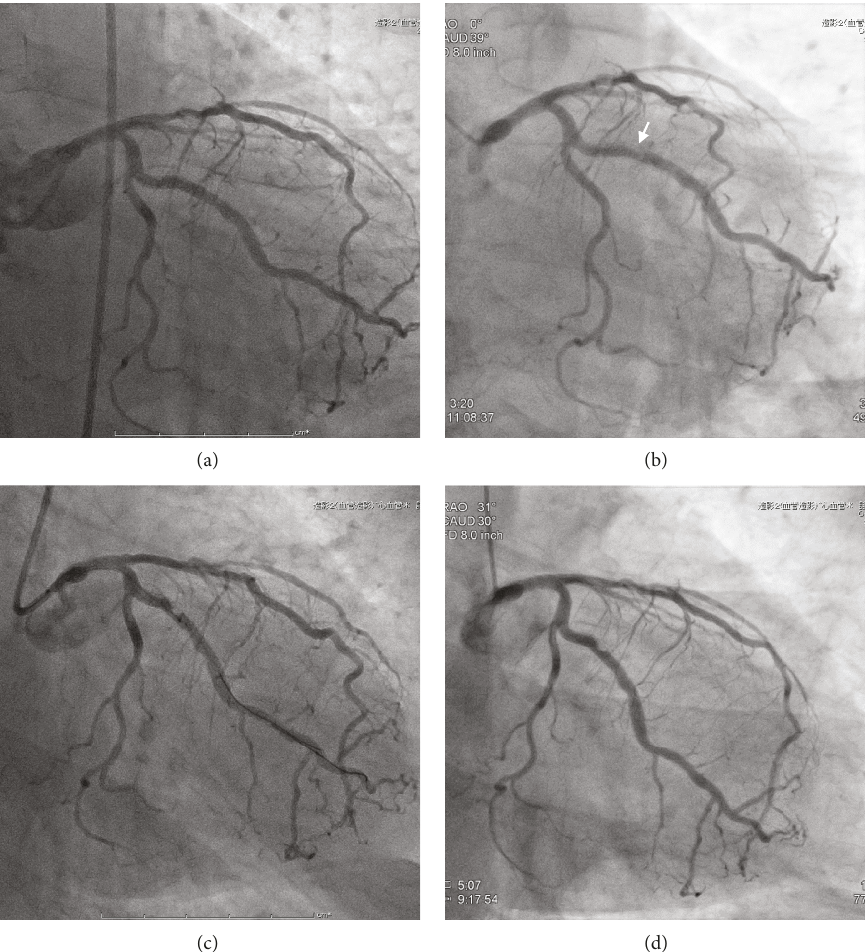
Figure 4: CAG fi ndings after second PCI. Although an additional drug-eluting stent sized 3.0 × 12 mm was implanted in #12 (a), CAG performed 3 days after the second PCI revealed the recurrence of thrombus (white arrow) with 75% haziness stenosis in #12 (b). Another CAG performed 14 days after the third PCI again revealed recurrence of stent thrombosis with 75% stenosis in #12 (c). The fi nal CAG, which was performed after the fourth PCI, showed 50% of residual stenosis with thrombus, and we decided not to perform further PCI to #12